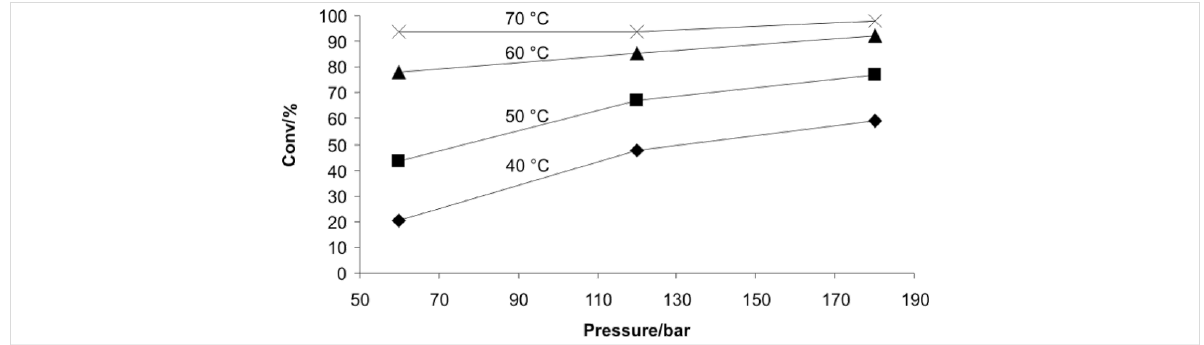
Figure 5: Nucleophilic aromatic substitution reaction of 1-fluoro-4-nitrobenzene ( 15 ) with pyrrolidine ( 16 ) in THF (Scheme 5) at different temperatures and three different pressures performed in a 8 mL stainless steel coil at a flow rate of 1